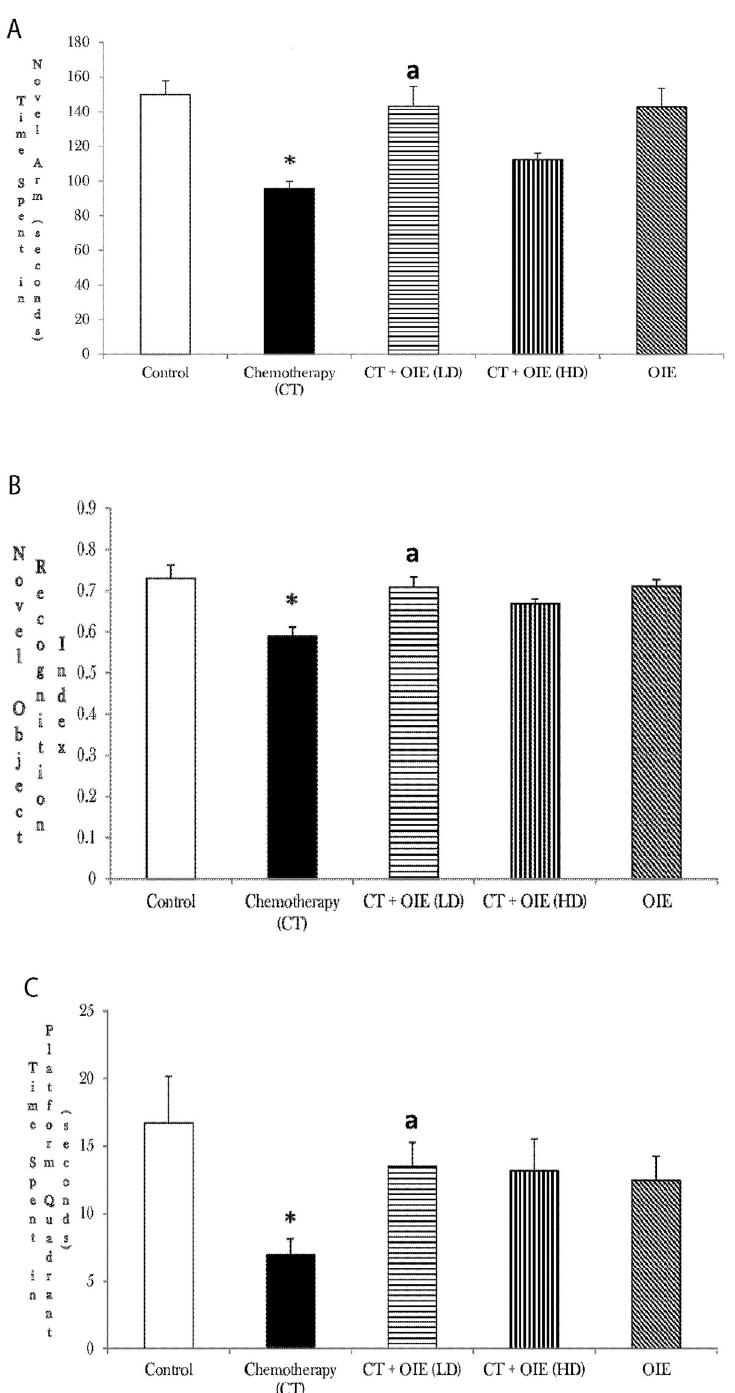
Fig 2. Effect of CT &/or OIE on spatial and recognition memory. (a) Y-maze test to determine spatial memory indicating time spent in the novel arm. (b) Recognition memory determined by NOR. Novel Object Recognition Index is a ratio of number of touches on the novel object / total number of touches on the familiar and novel object. (c) Morris water maze test for spatial learning and memory. Time spent in the platform quadrant was recorded. Results shown are expressed as the mean ± SEM (n = 10) � p < 0.05 vs. control mice, a p < 0.05 vs. CT mice.